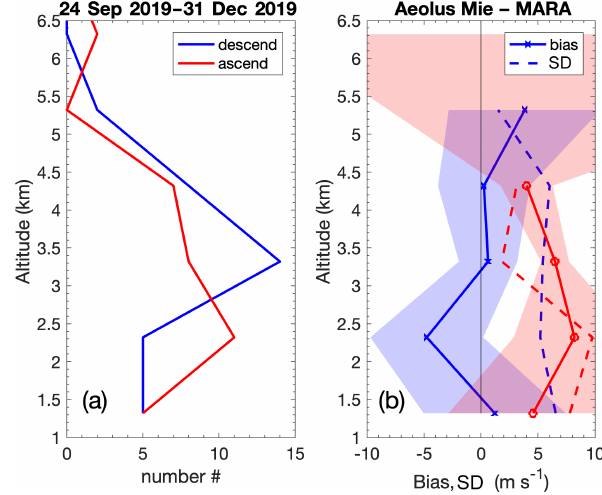
Figure 8. The same as Fig. 5 but for Aeolus Mie HLOS winds against MARA